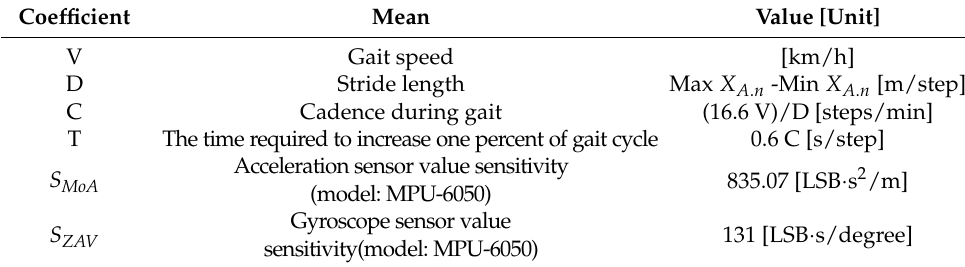
Table 1. Coefficients used in acceleration and angular velocity